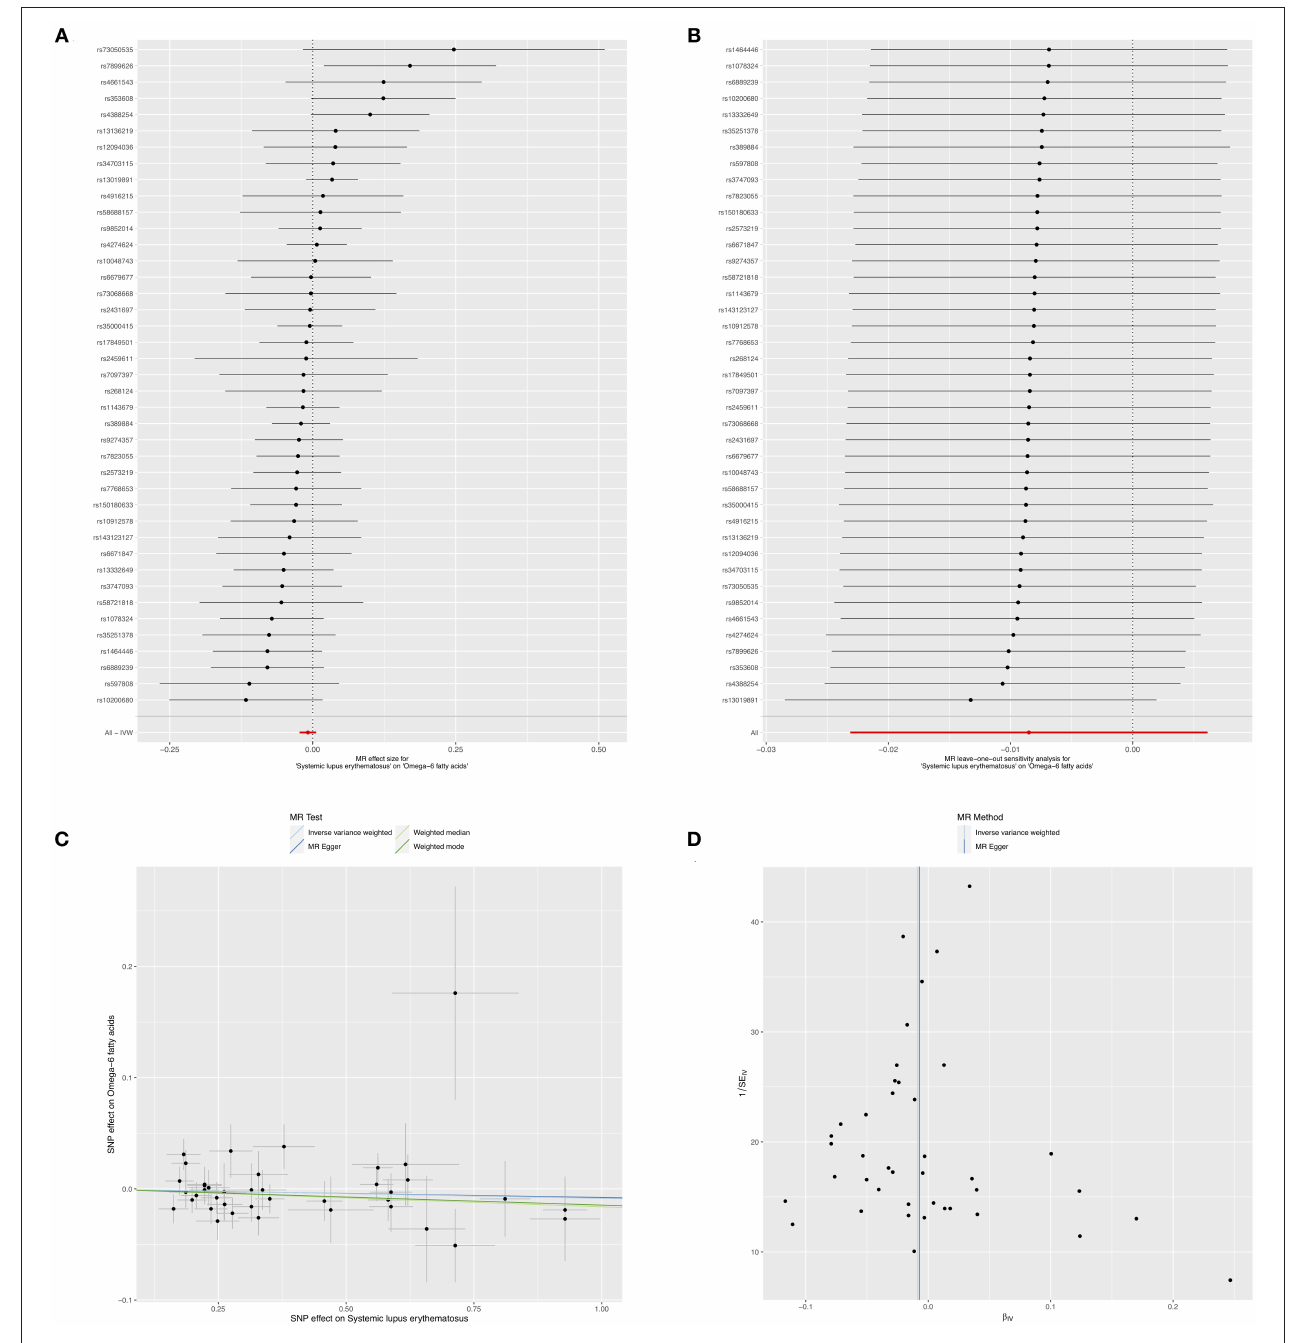
FIGURE 5 | Mendelian randomization study of the effects of SLE on omega-6 levels. Forest plot (A) , leave-one-out sensitivity analysis (B) , scatter plot (C) , and funnel plot (D) of the genetically risk of SLE on circulating omega-6 levels.